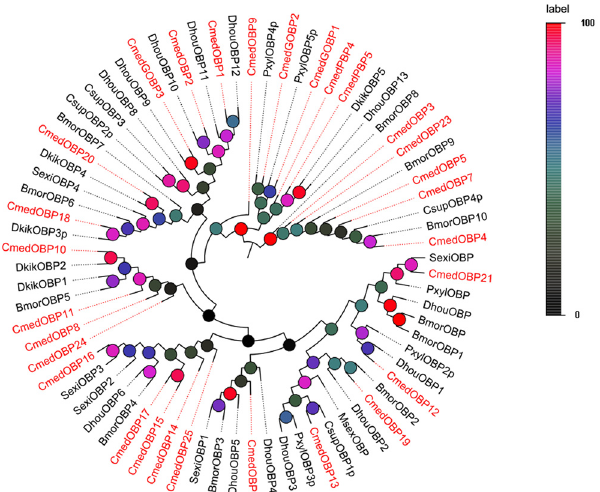
Fig 5. Phylogenetic tree of candidate CmedOBPs with known OBP sequences of other species. Harm: H . armigera ; Hvir: H . virescens ; Bmor: B . mori ; Pxyl: P . xylostella ; Hass: H . assulta ; Msex: Manduca sexta , Sexi: Spodoptera exigua ; Slit: Spodoptera littoralis ; Dkik: Dendrolimus kikuchii ; Dhou: Dendrolimus houi ; Dple: Danaus plexippus ; Csup: Chilo suppressalis .